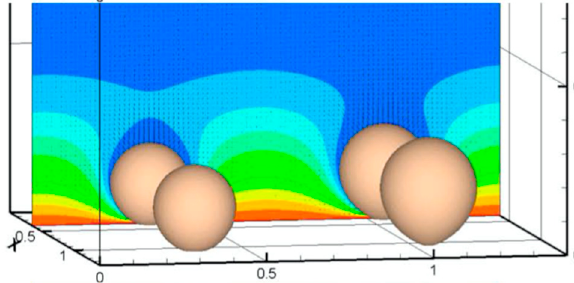
Figure 9. Example of interface-capturing simulation of boiling at the scale of the single steam bubbles, from Tryggvason et al. [43]. Computational meshes used for this kind of simulation are required to resolve the details of the vapour–liquid interface (grey surface in the figure), typically resulting in cell sizes of a few micrometres in realistic boiling conditions.